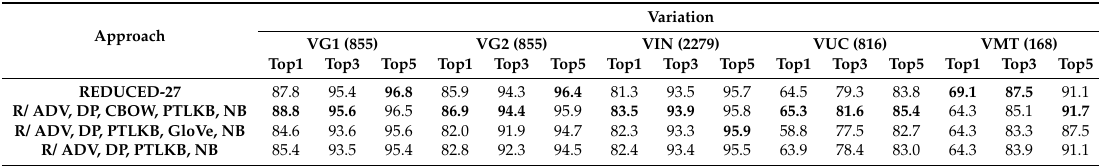
Table 10. Proportion of variations of different types correctly matched with original FAQs (Top1), in Top-3 and in Top-5 most similar, using different reduced models.